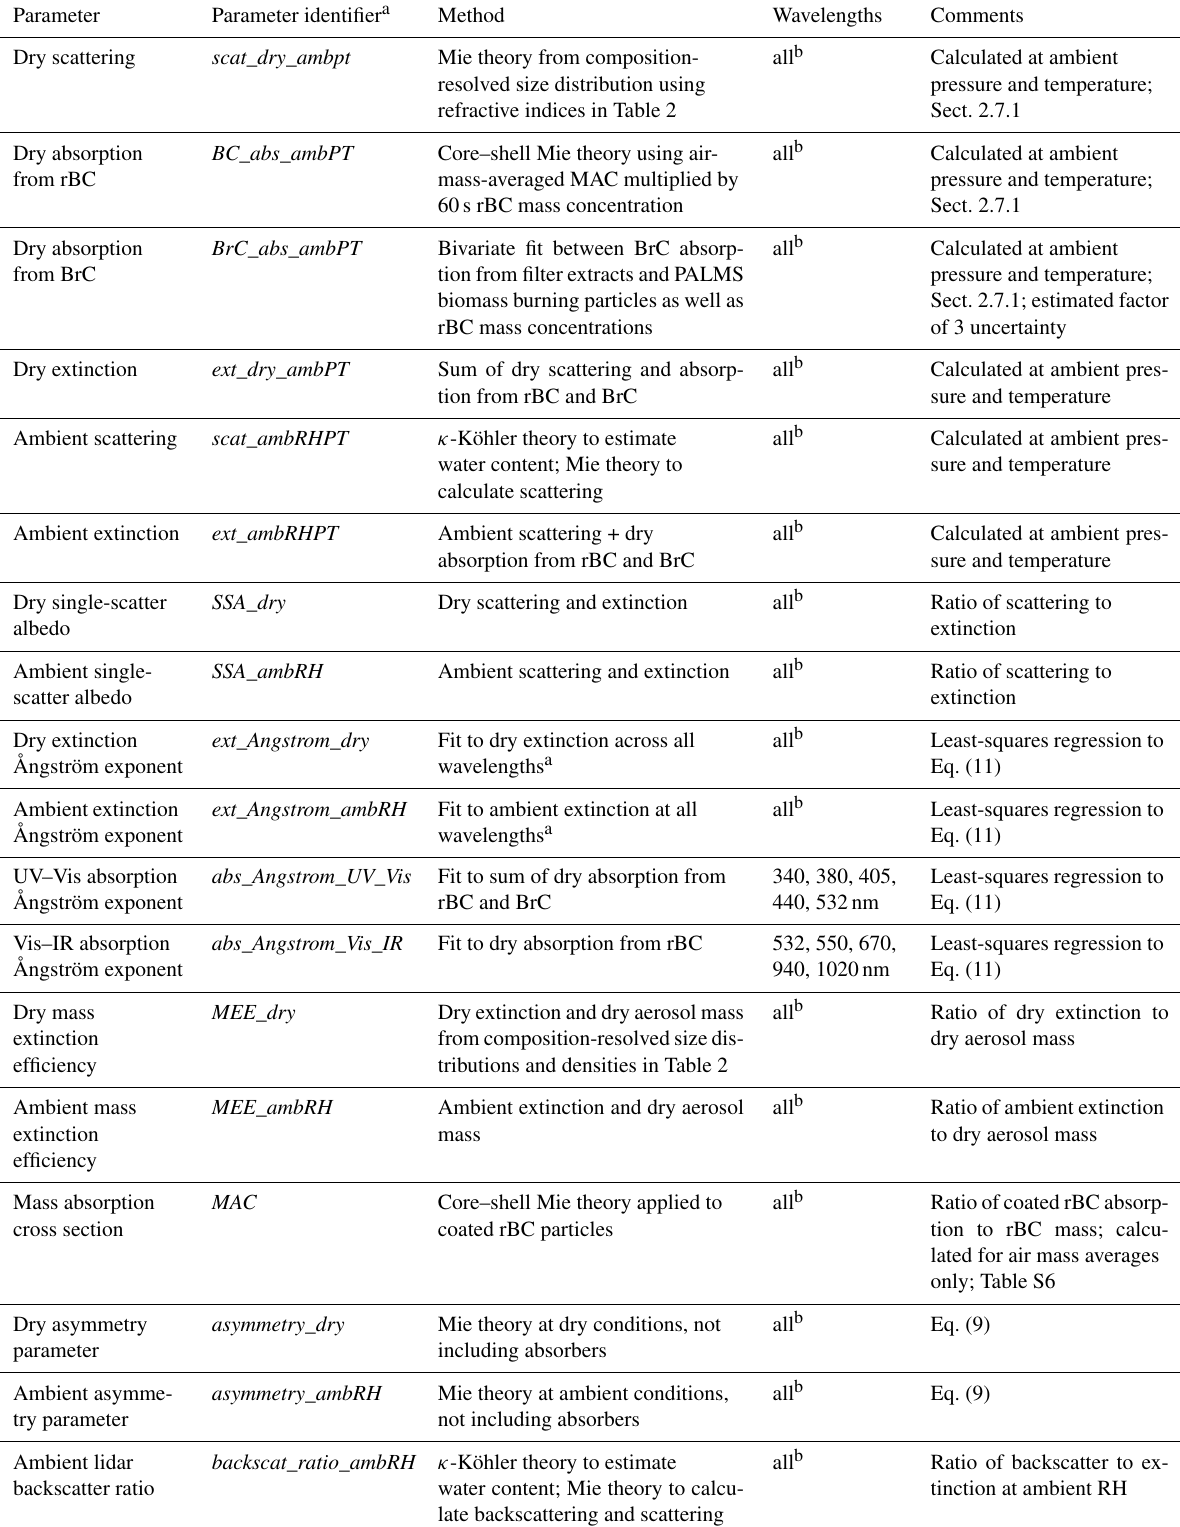
Table 1. Aerosol properties calculated from the combined aerosol dataset and archived in